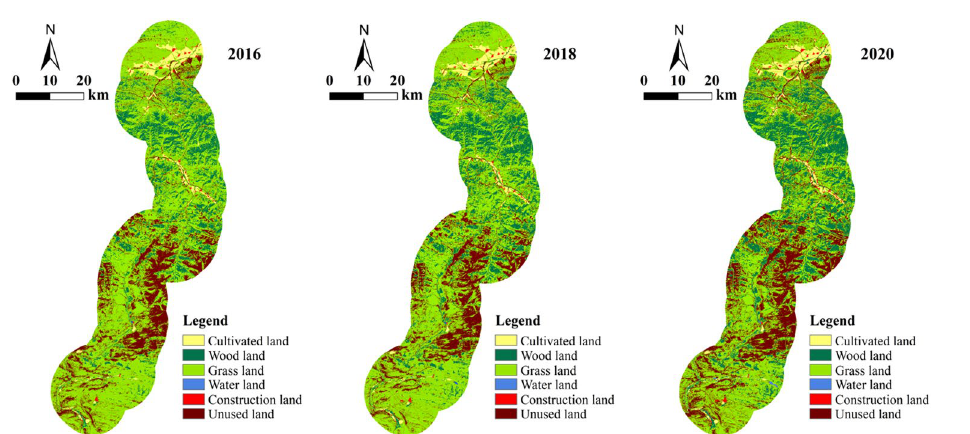
Figure 3. Map of land usages in the study area from 2016 to